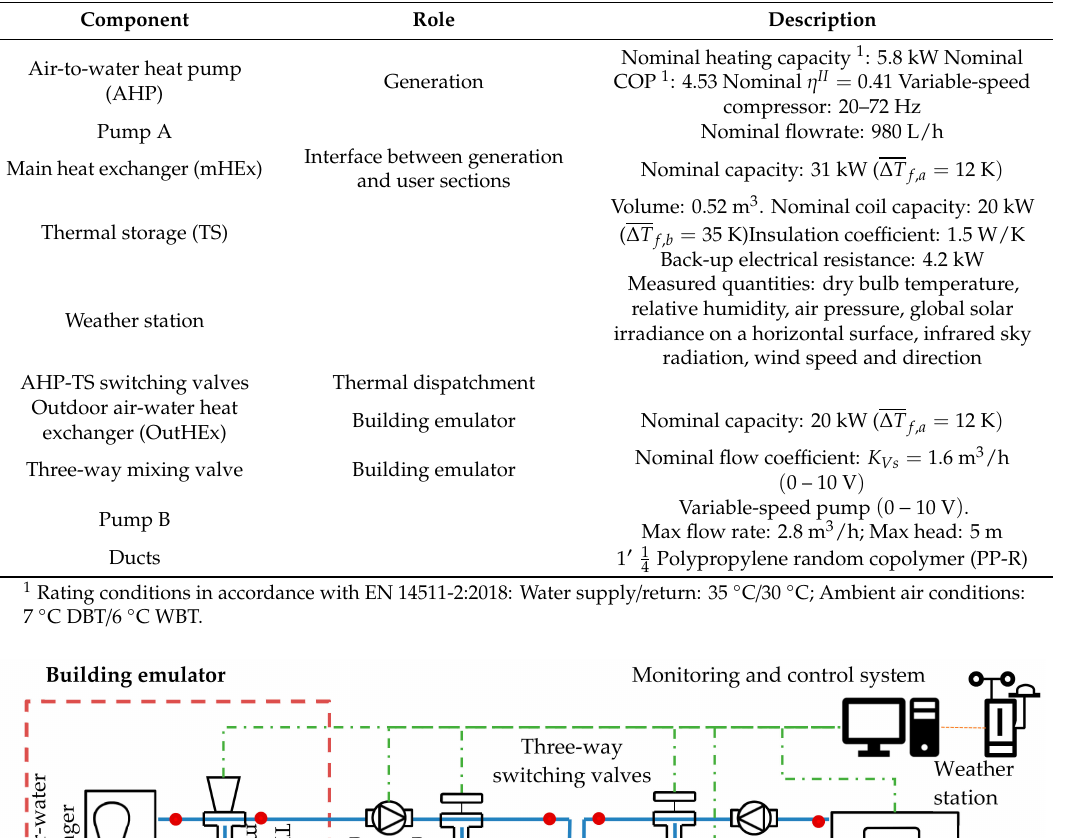
Table 1. Components of the BE-IES “Hardware-in-the-Loop” Apparatus.